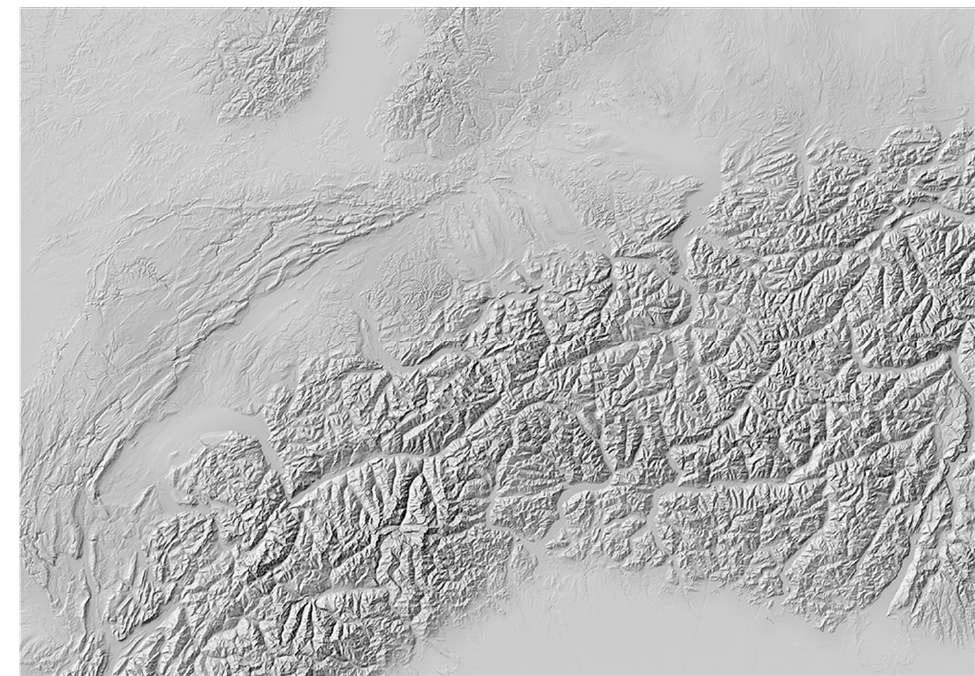
Figure 9. Second-choice blended shaded reliefs.